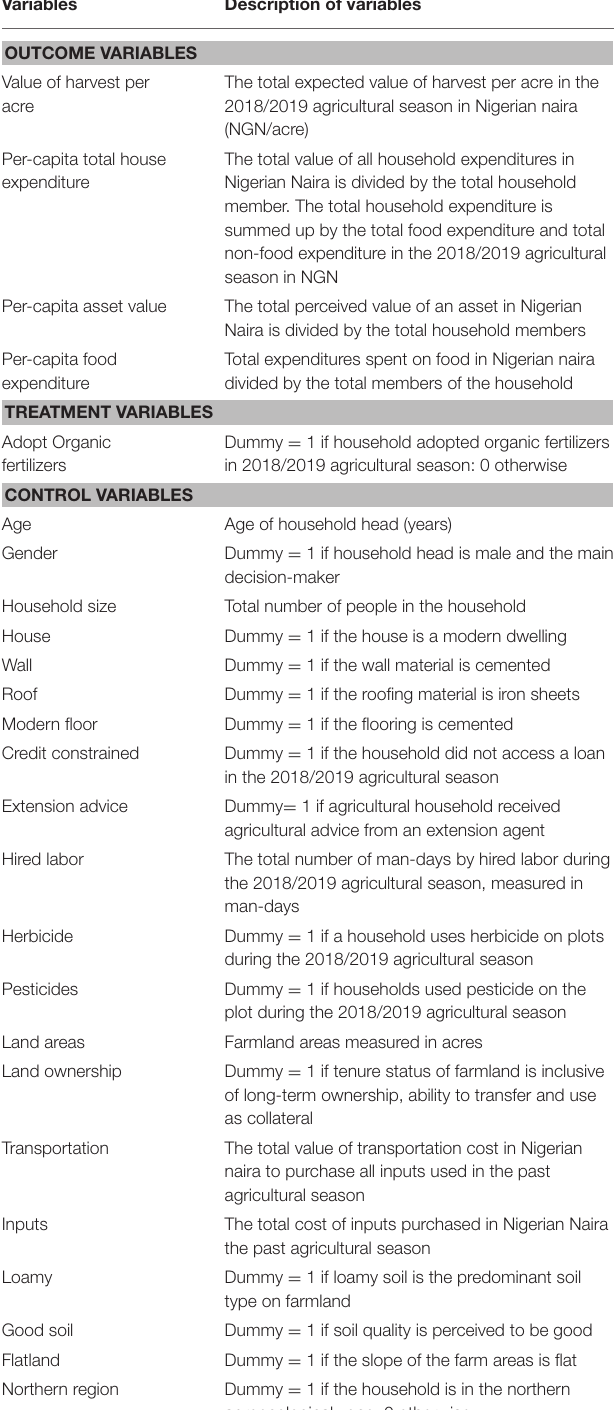
TABLE 1 | Description of